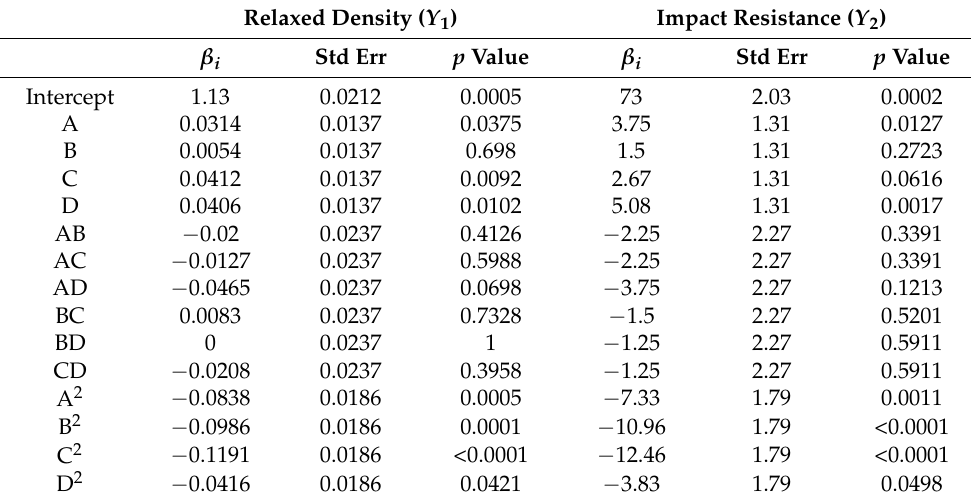
Table 4. Coefficients in terms of coded factors.